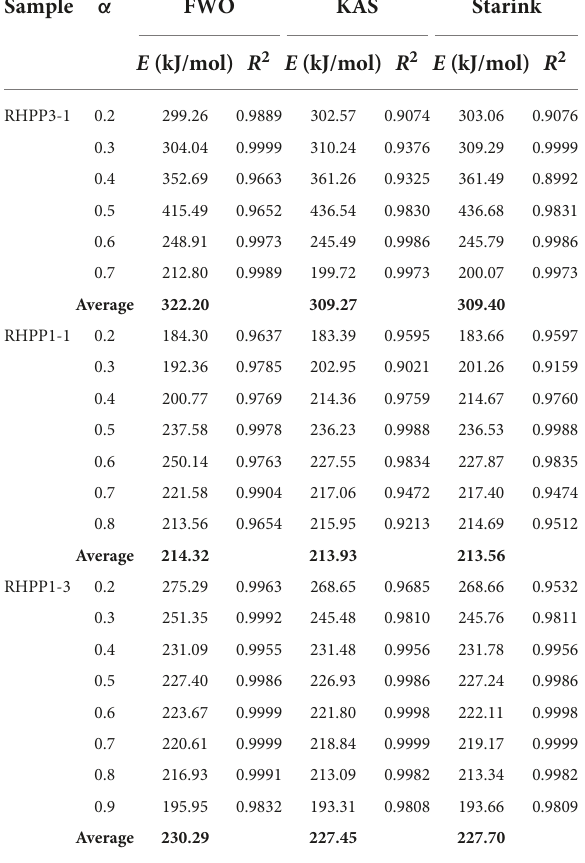
TABLE 5 Kinetics parameters of RH and PP mixtures solved by isoconversional methods. Sample α FWO KAS Starink